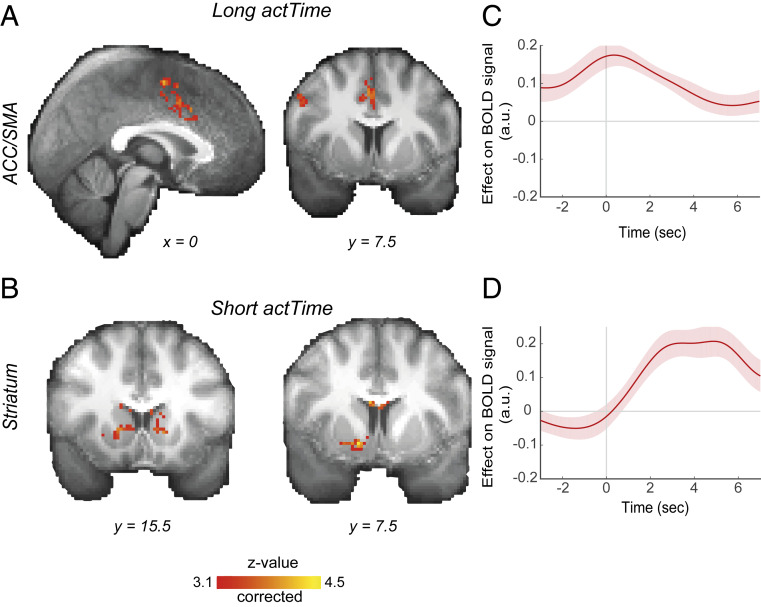
BOLD signal in ACC and striatum is correlated with time to act. Whole-brain analysis showing voxels where activity reflected parametric variation in the empirically observed actTime, on trials where rate of change in reward probability was (A) positive (long actTime was the correct strategy) and (B) negative (short actTime was the correct strategy). Whole-brain cluster-based correction, Z > 3.1. (See SI Appendix, Table S1 for the list of clusters.) (C and D) ROI time course analysis of the ACC/SMA (C) and striatum (D), showing the relationship between BOLD and actTime. Time 0 is the response time. Note that the hemodynamic lag means that a BOLD signal change reflects neural activity ∼6 s earlier. The lines and shadings show the mean and SE of the β weights across the participants, respectively. See also SI Appendix, Table S1.